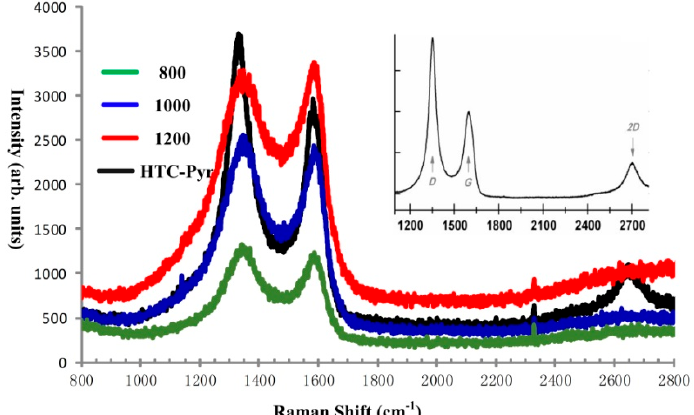
Figure 10. The Raman spectra of GMC samples prepared at four temperatures: 800 °C (green), 1000 °C (blue), 1200 °C (red), and using an HTC-Pyr (black) technique. The Raman spectra of GMC samples are very similar to the Raman spectrum (see inset) of rGO (www.nanonics.co.il), indicating the presence of graphene sheets in the GMC samples. However, the oxygen fraction in GMC samples is less than that in rGO.